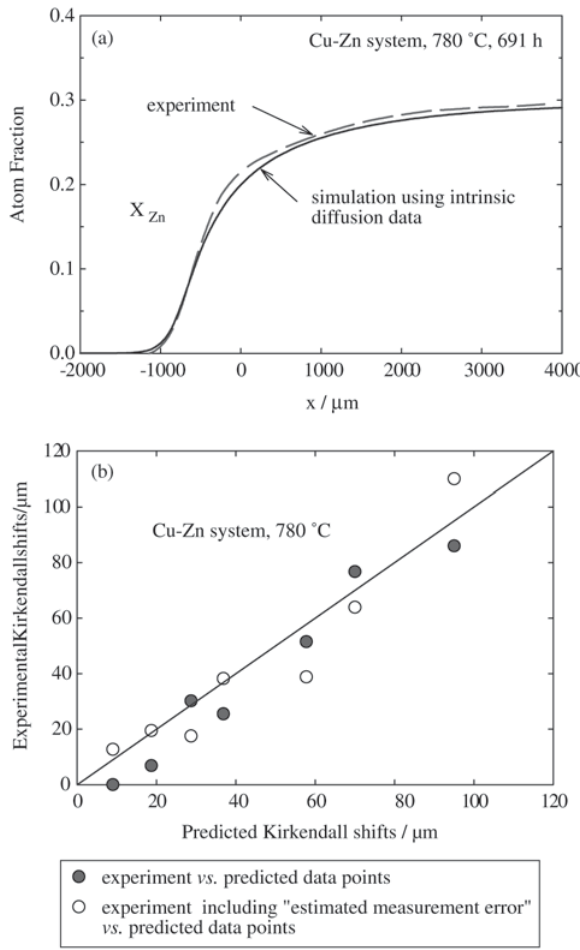
Figure 9. a) Composition profile and b) Kirkendall shifts for the Cu-Zn system 32 obtained using the experimentally determined in- trinsic diffusion coefficients as inputs to the diffusion simulation software.